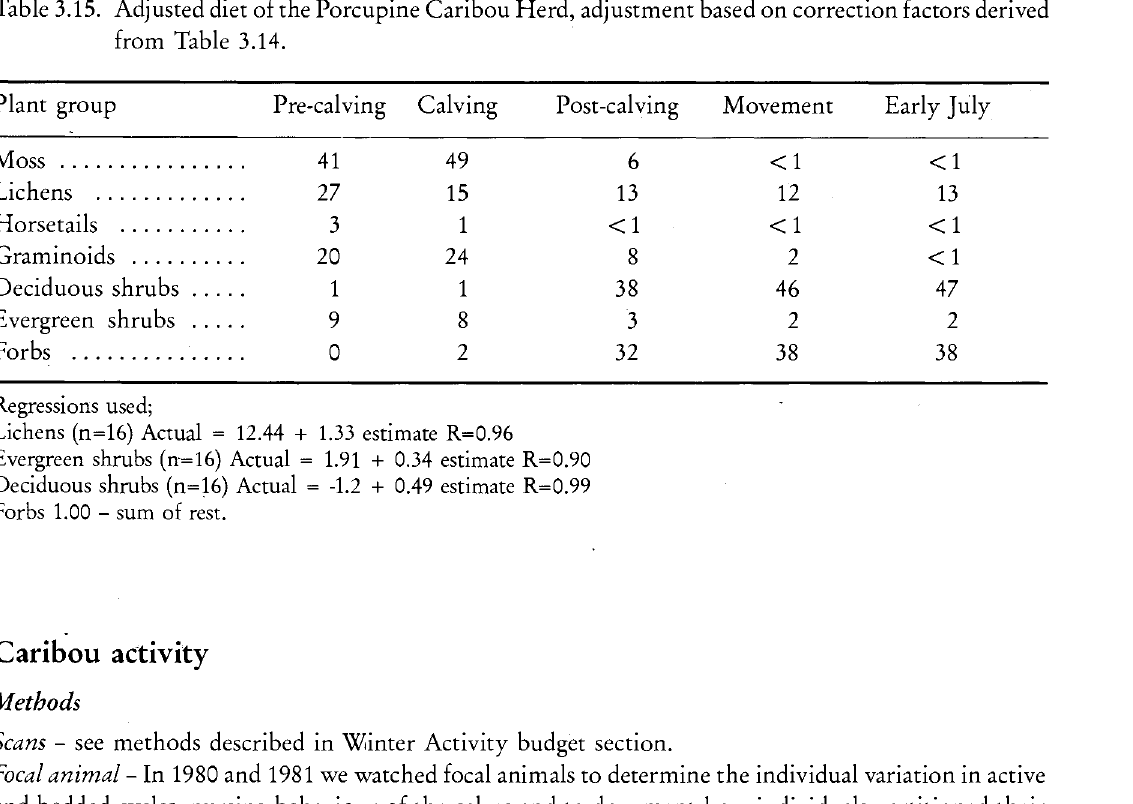
Table 3.15. Adjusted diet of the Porcupine Caribou Herd, adjustment based on correction factors derived from Table